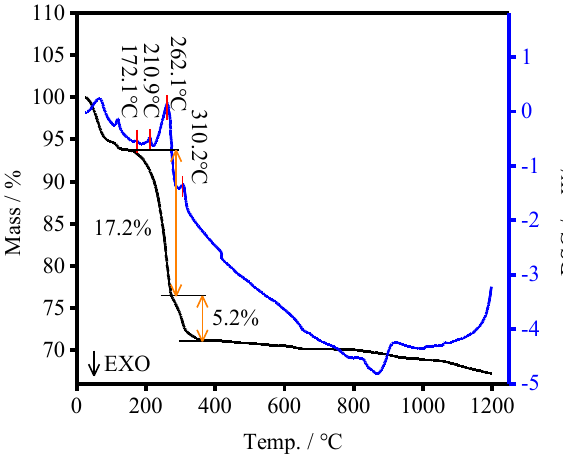
Cl and EBFS mixture. 4 Figure 7. Effect of various particle sizes on iron removal rate over time Figure 7: Effect of various particle sizes on iron removal rate over